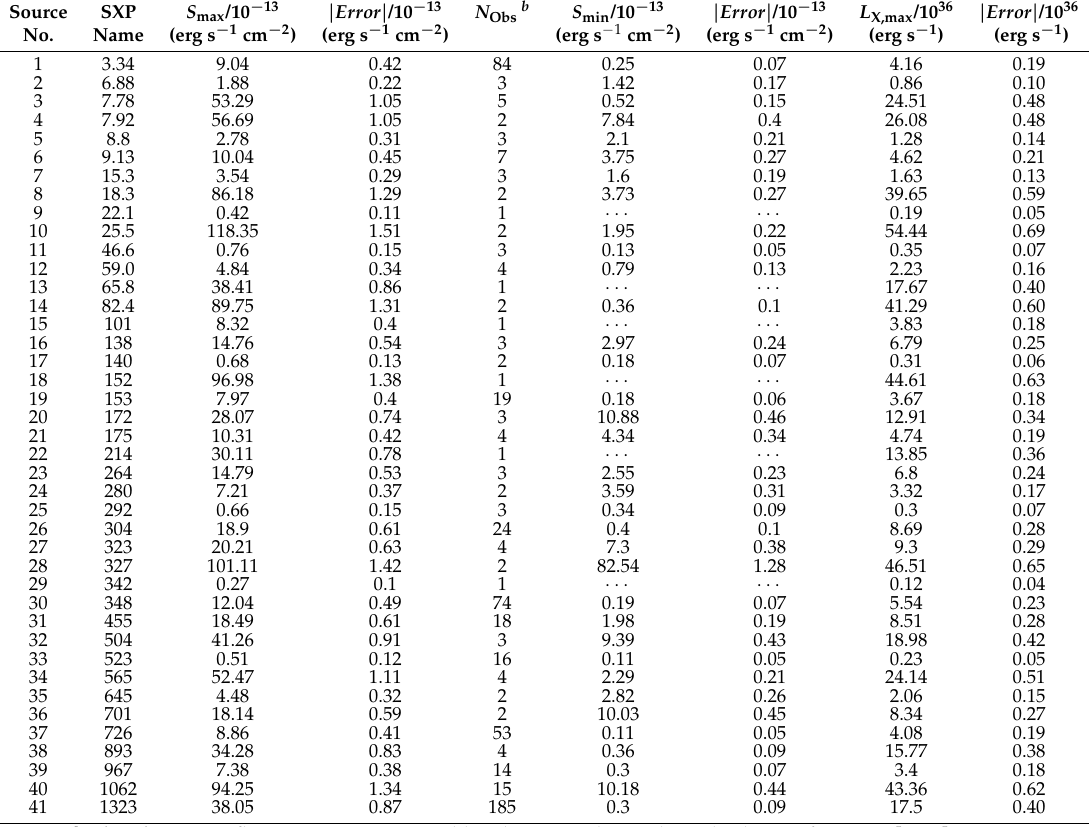
Table 1. SMC SXP fluxes (0.3–8 keV) observed by Chandra (ACIS-I) a